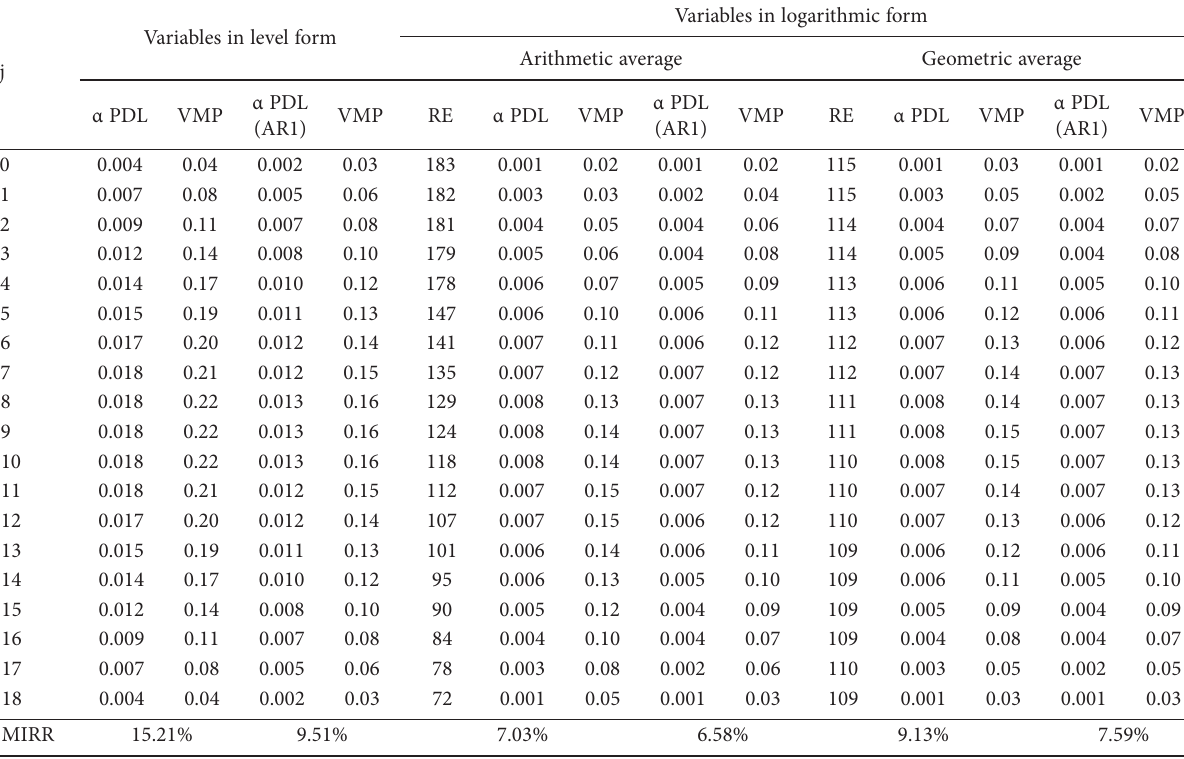
Table 4. Computation of the Internal Rate of Returns (IRR) for the TFP